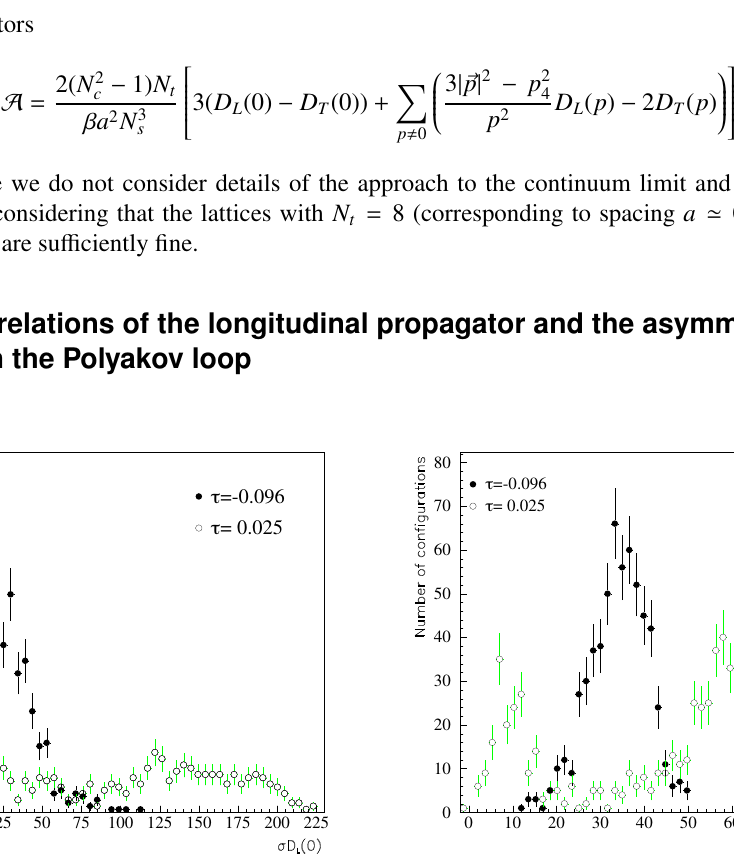
Figure 1: Distributions in the zero-momentum longitudinal propagator (left panel) and the asymmetry (right panel) at T < T c (filled circles) and T > T c (empty circles).